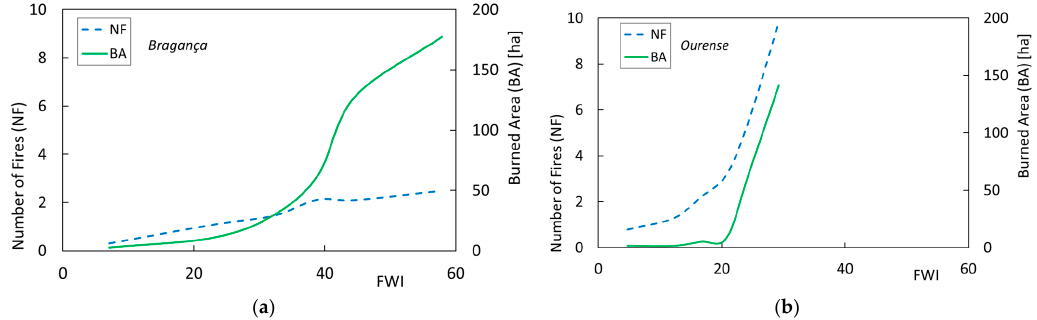
Figure A4. Average number of daily fires (NF) and burned area (BA) as a function of FWI for: ( a ) the Portuguese District of Bragança and ( b ) the Spanish Province of Ourense.